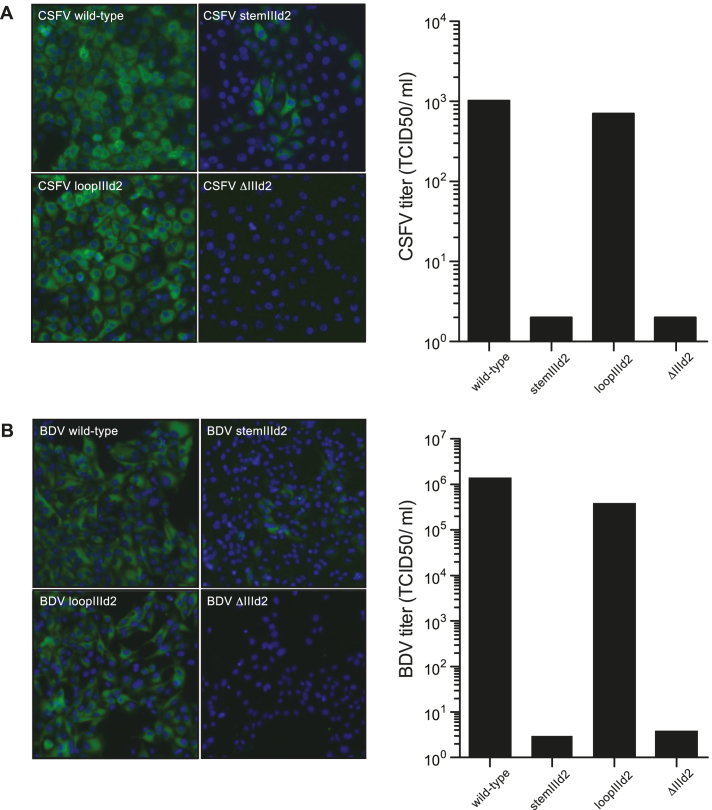
Deletion of the IRES sub-domain IIId2 from the pestiviruses BDV and CSFV impairs infection. (A) Full-length RNA transcripts derived from the wt CSFV Paderborn cDNA (pBeloPader10) and its indicated derivatives were introduced into PK-15 cells using electroporation. After 72 h, the cells were fixed and stained with antibodies against the pestivirus NS3 protein and the nuclei were visualized using DAPI. The viral titres in the cell supernatants prepared at 72 h were determined as TCID50/ml using virus titration in PK-15 cells. The data presented are representative of three independent biological replicates. (B) Full-length RNA transcripts derived from a wt BDV Gifhorn cDNA (in pBeloGif09.9.2) and its indicated derivatives were introduced into ovine SFT-R cells using electroporation. After 72 h, the cells were fixed and stained with antibodies against the NS3 protein and the nuclei were visualized using DAPI. The viral titres in the cell supernatants prepared at 72 h were determined as TCID50/ml using virus titration in SFT-R cells. The data presented are representative of three independent biological replicates.